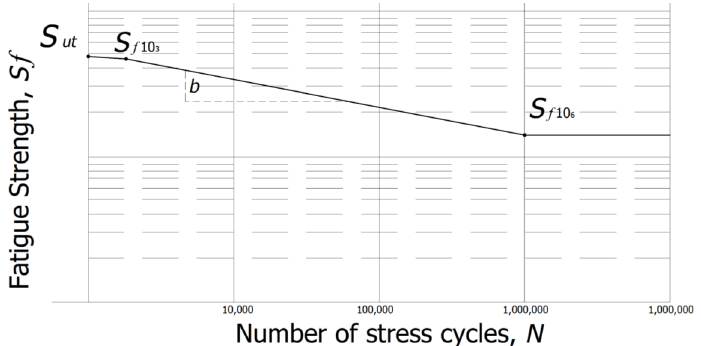
Figure 1. S-N diagram plotted from the fatigue strength analysis.